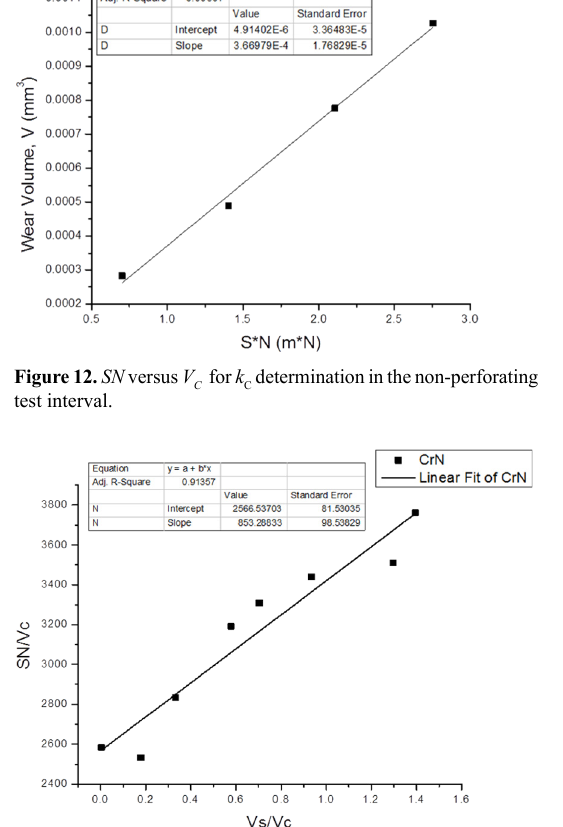
for simultaneous determination of C